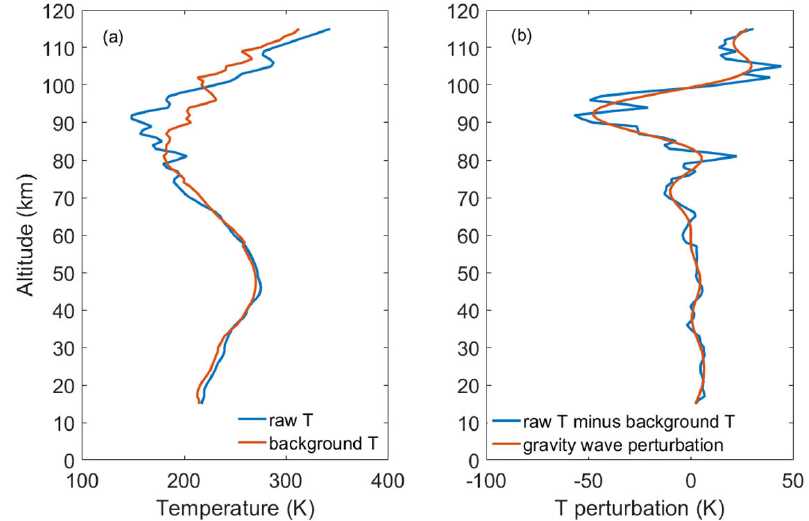
Figure 2. ( a ) Raw and background temperature profiles of one sounding sampled at (–50°, 337°) on 14 January 2004. ( b ) Difference between raw temperature and background temperature and the corresponding gravity wave perturbation profile (low ‐ pass filtered).